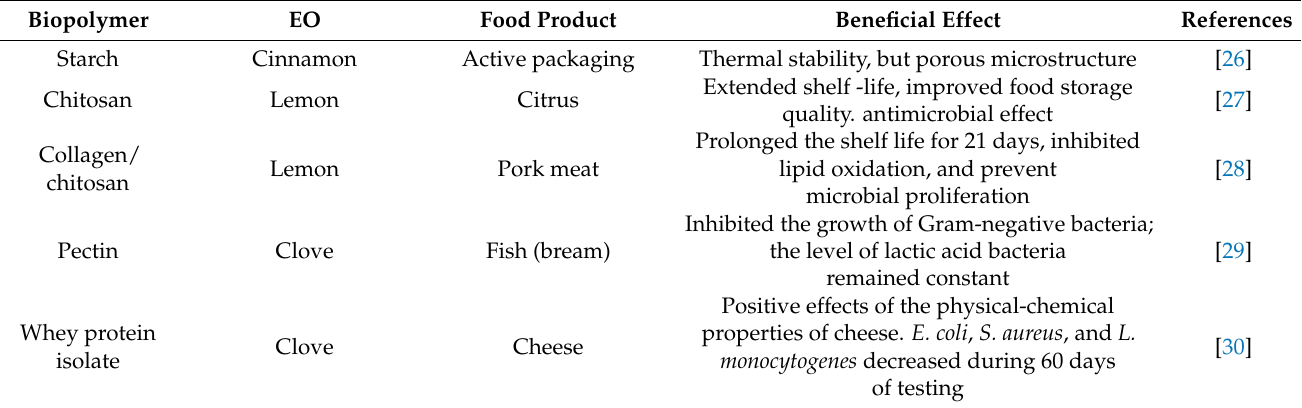
Table 1. Examples of bio-based films incorporating essential oils (EOs) with antimicrobial